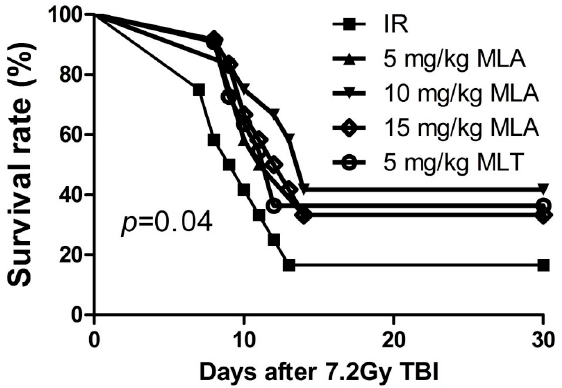
Figure 2. Effects of MLA on the survival of mice exposed to TBI (7.2 Gy). Before the mice ( n = 12)